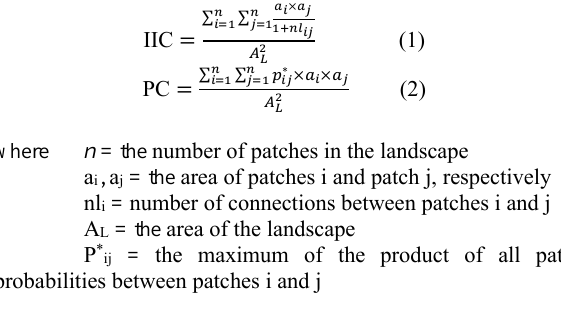
Table 1 . Ecological implications of